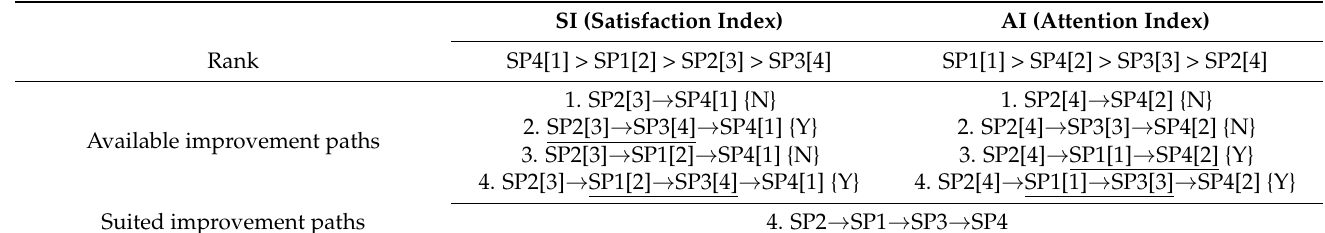
Table 11. The suited improvement paths of the SP (skill and practice)